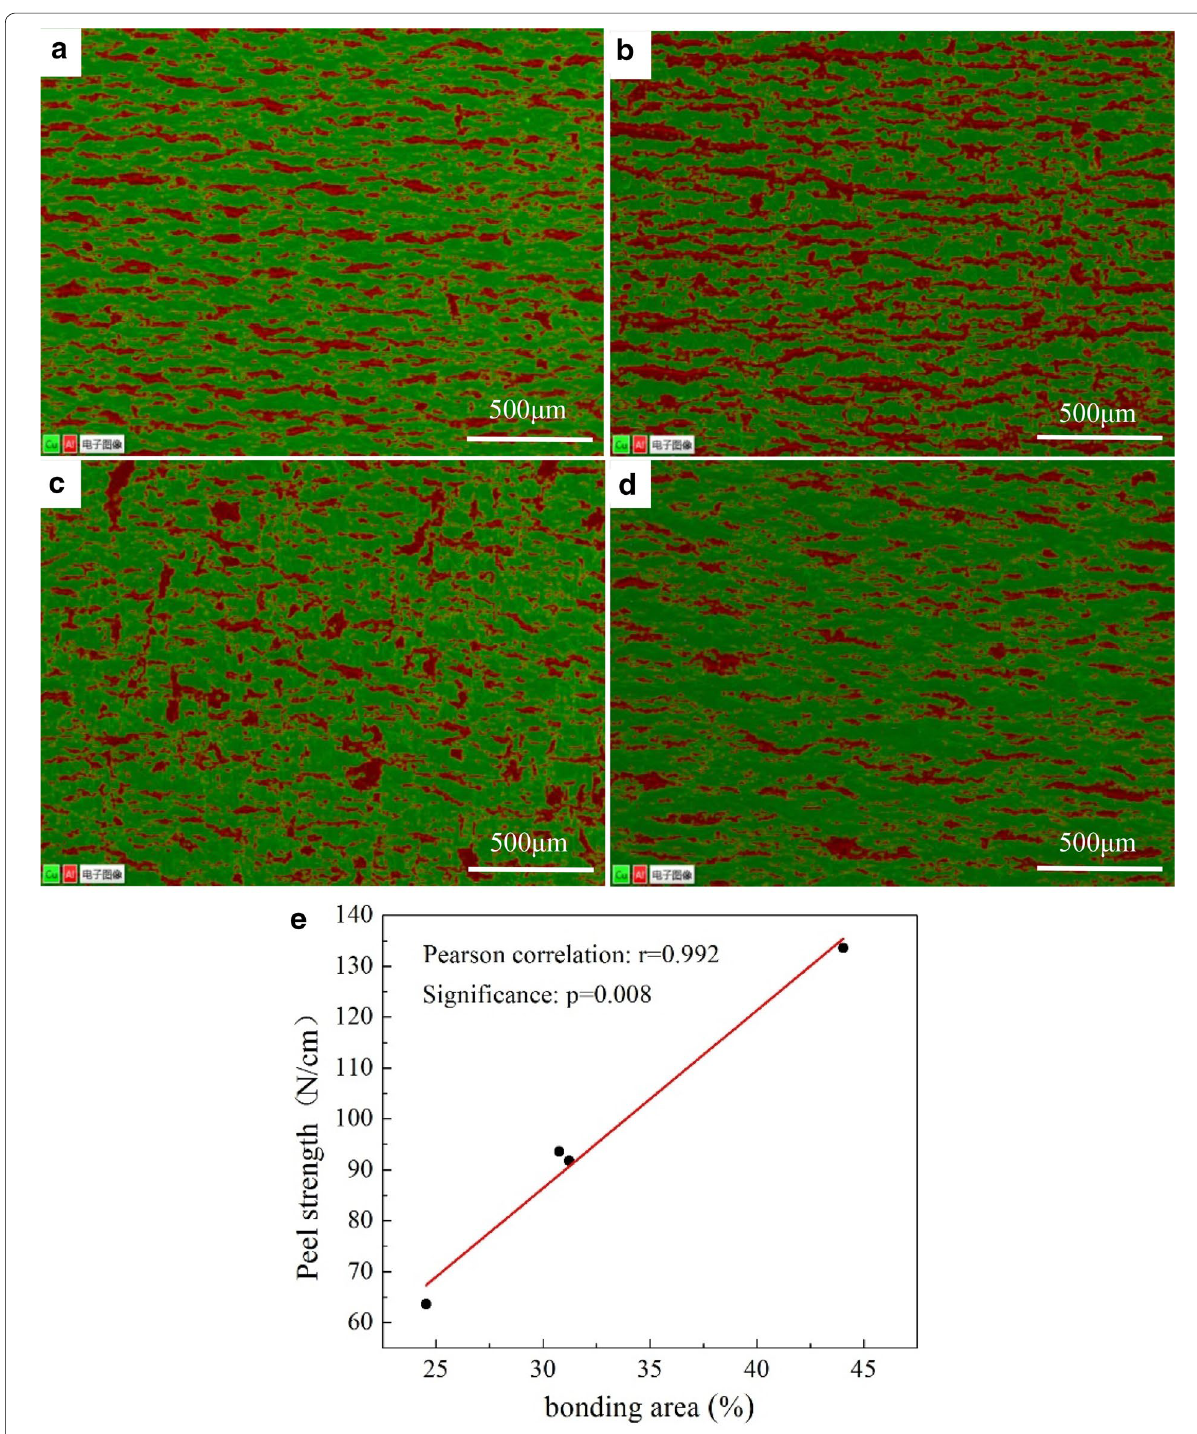
Fig. 9 Map scanning and bivariate correlation analysis of the peeling fracture surface: a VRDG; b PRDG; c 90° CG; d RWBG; e bivariate correlation